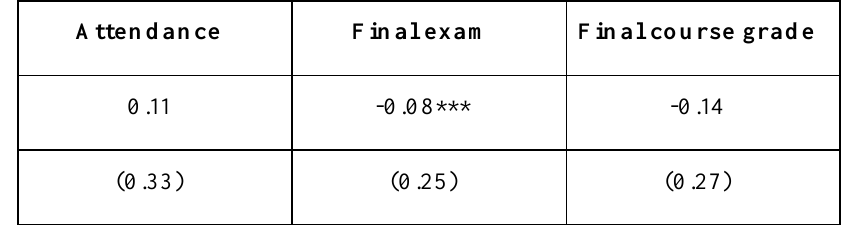
Estimation of the Effect of Open Textbooks Versus the Use of Traditional Textbooks (Scenario